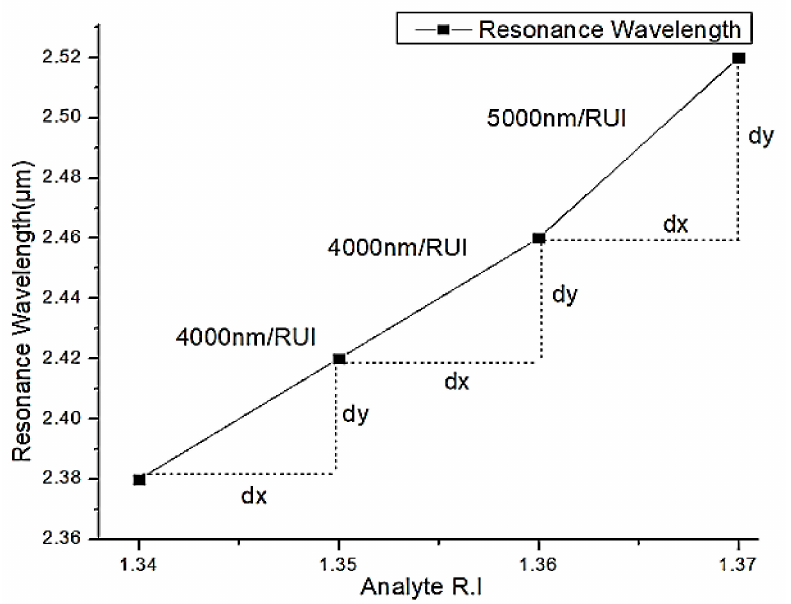
Figure 14. Sensor sensitivity measurement using resonance wavelength shift with reference to analyte RI changes. Table 1. Comparison of our proposed work with contemporary